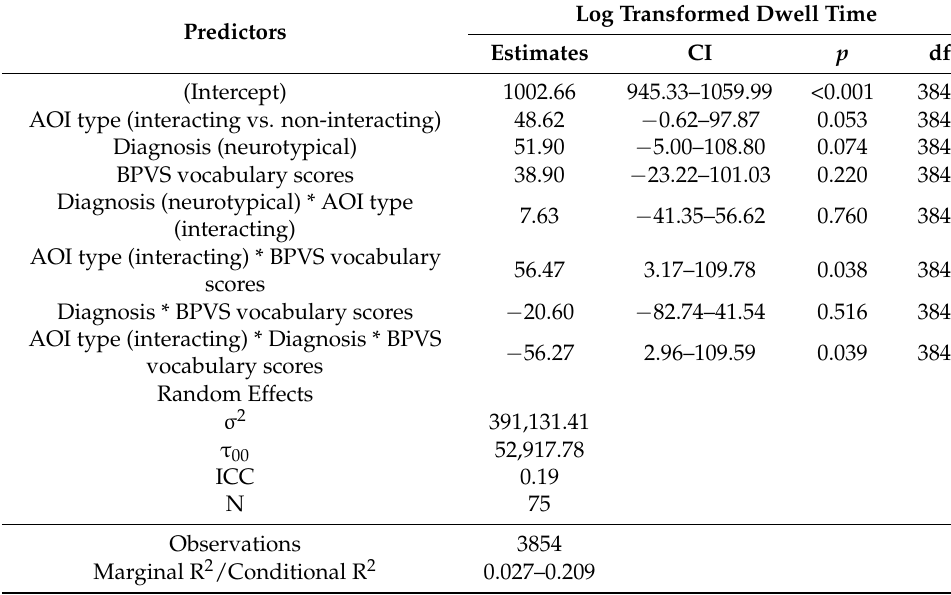
Table 5. Fixed and random effects as a summary of the linear mixed model with vocabulary scores for the whole figure AOIs. The conditional R 2 accounts for the variance explained by the whole model, while the marginal R 2 accounts for the fixed effects